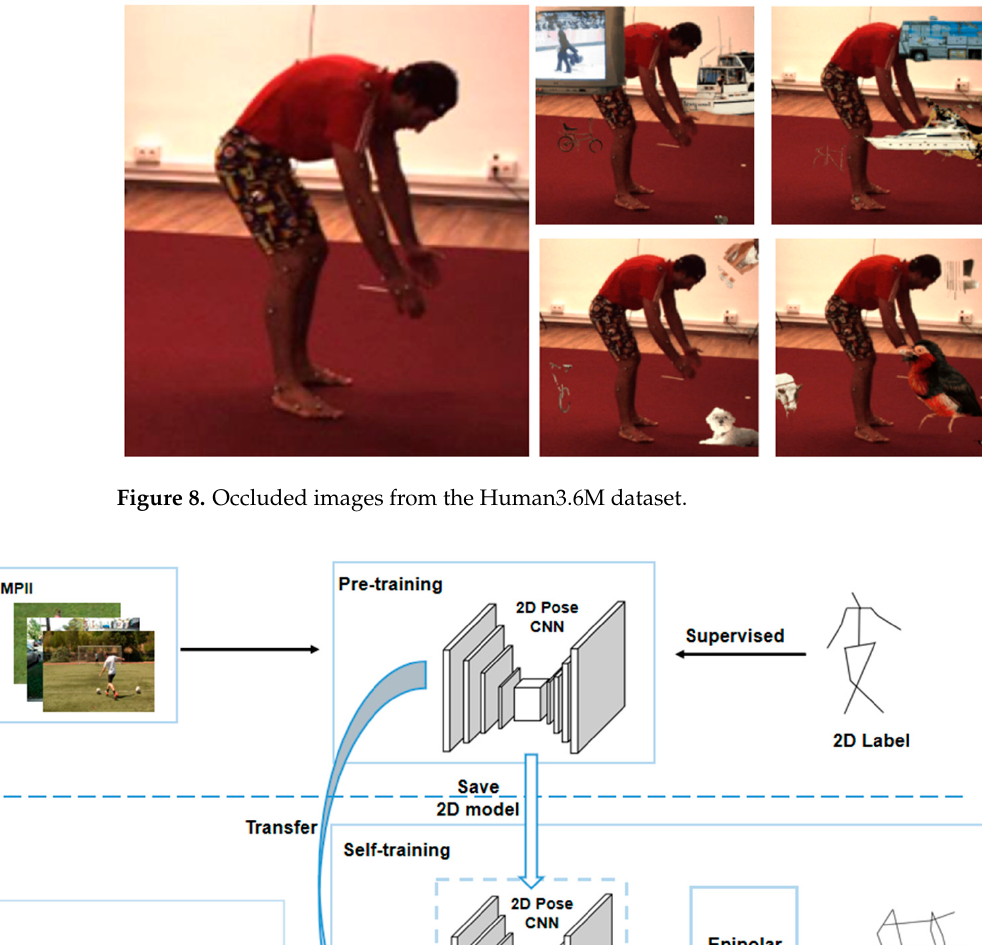
Figure 8. Occluded images from the Human3.6M dataset.